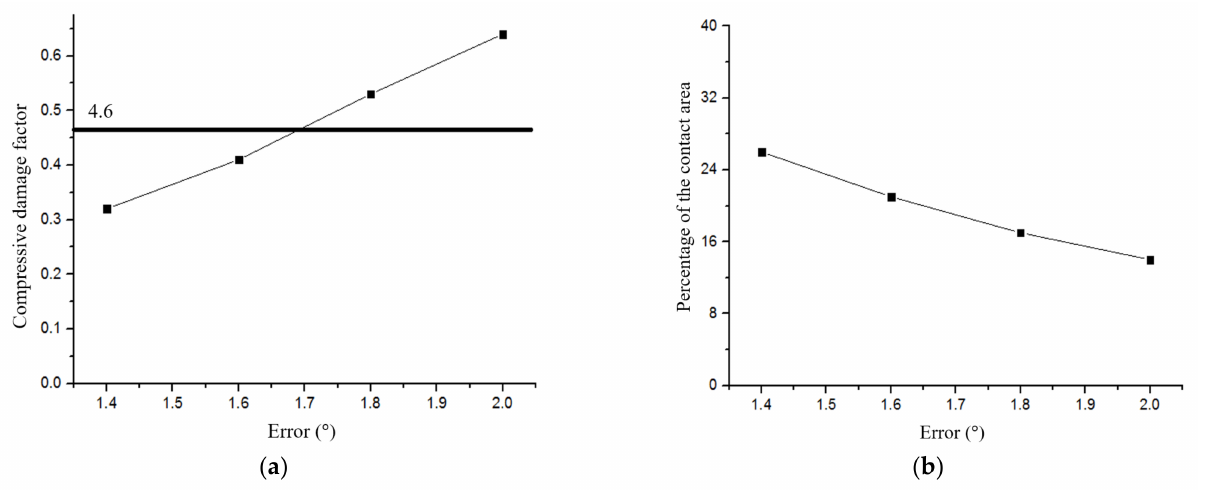
Figure 22. Maximum compression damage factor and contact area of the T-LZ block under rZ direction error. ( a ) Maximum compression damage factor; ( b ) Contact area of the T-LZ